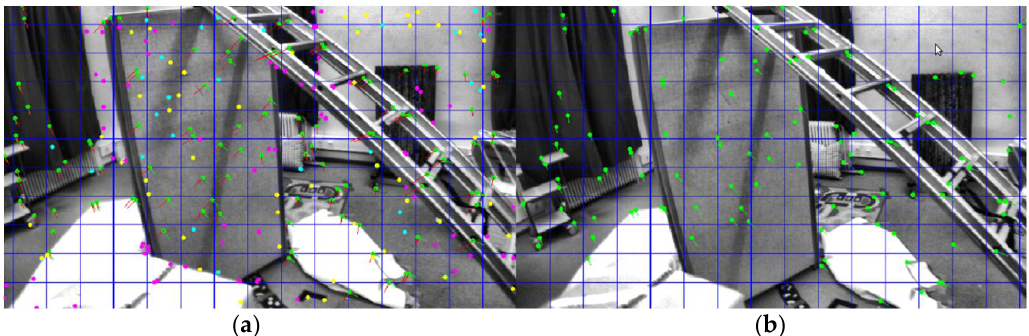
Figure 3. Mismatch accuracy of different types of cameras.